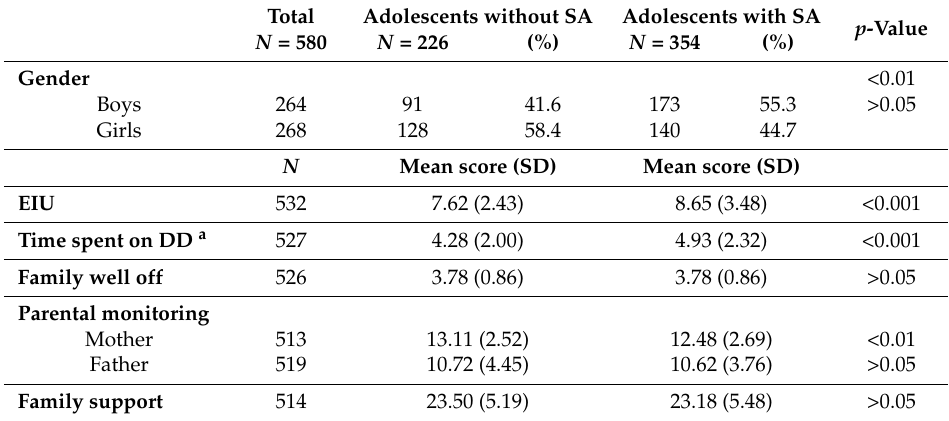
Table 1. Descriptive statistics by subculture affiliation (SA).